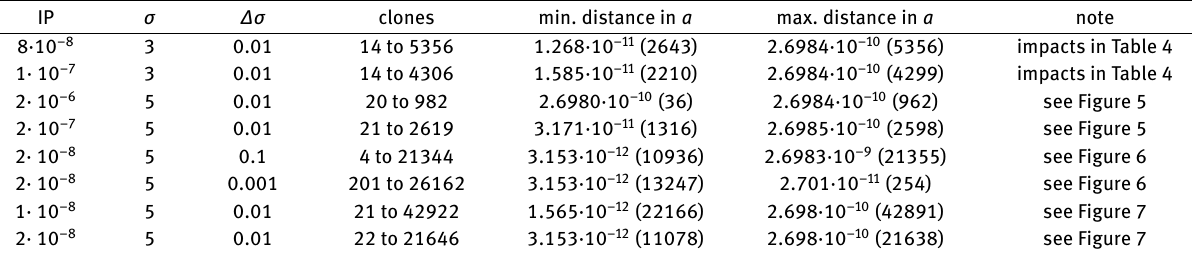
Figure 6. The same as in Figure 5 but for σ max =5 and IP = 2· 10 −8 . Additionally, ∆σ max =0.1 which gives 21341 multiple solutions for top ∆ panels and ∆σ max =0.001 with 25962 multiple solutions for bottom panels. For better visibility, the sigma-axis is limited to the range (−3, −1). Table 5. The asteroid 2001BB16. The LOV 2 method. The dependence on the used IP parameter. The non-gravitational